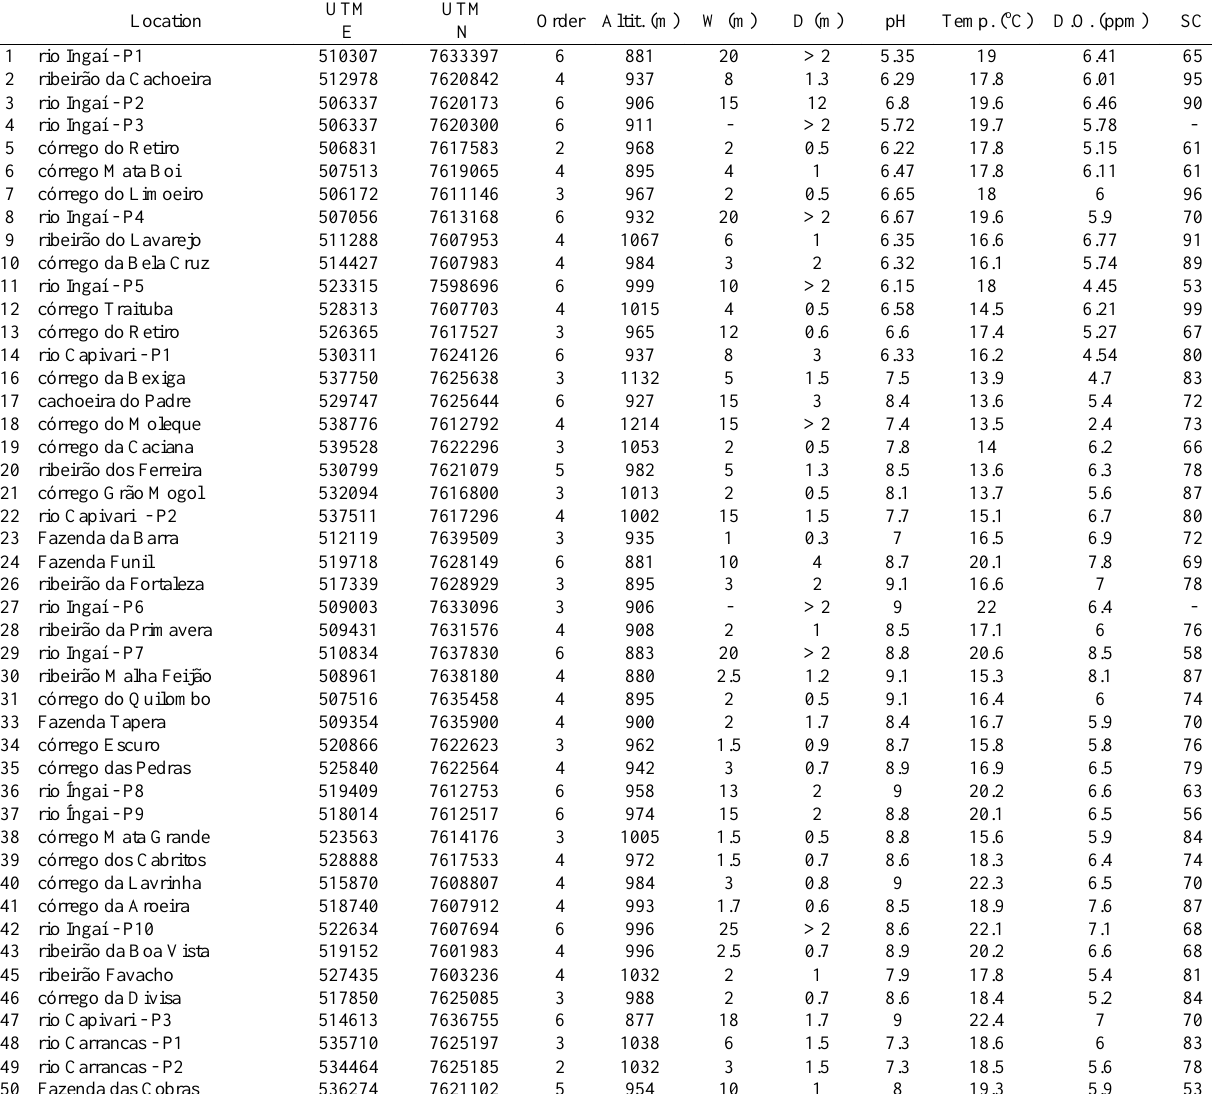
Table 1. Location and characterization of sampling points in upper Capivari basin (Altit. = altitude; W = width; D =